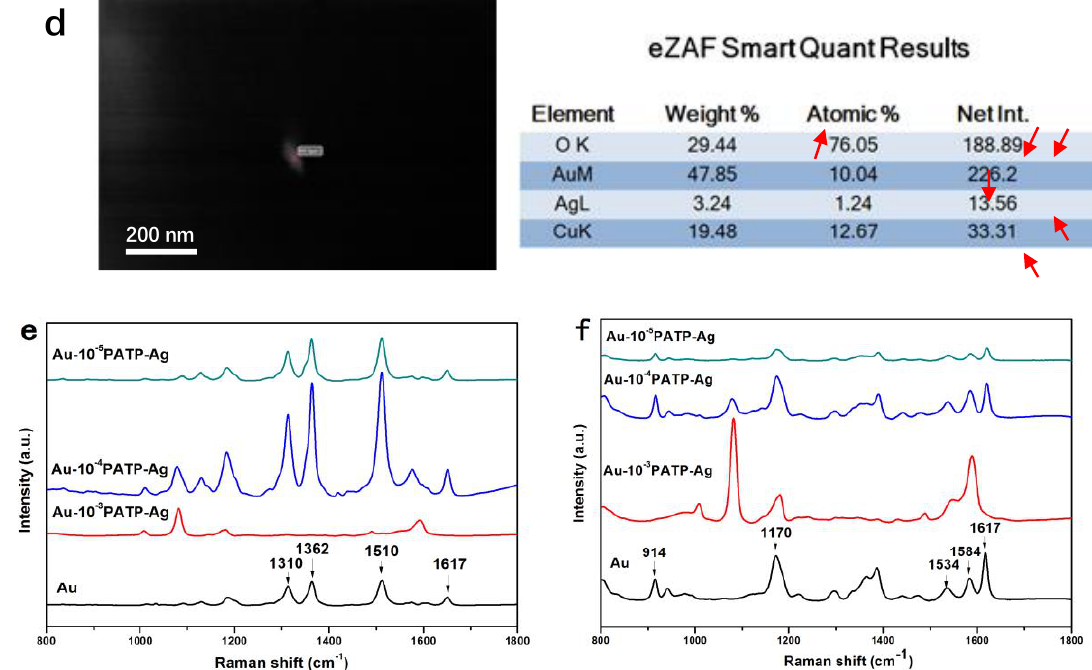
Figure 3. ( a–c ) TEM images of Au@Ag NPs modified with different concentrations of (5 × 10 –5 , 5 × 10 –4 , and 5 × 10 –3 M, respectively); ( d ) the EDX analysis for Au@Ag NPs modified with 5 × 10 –4 M with 4-PATP, ( e,f ) Raman SERS spectra obtained from R6G and CV with different metal NPs.